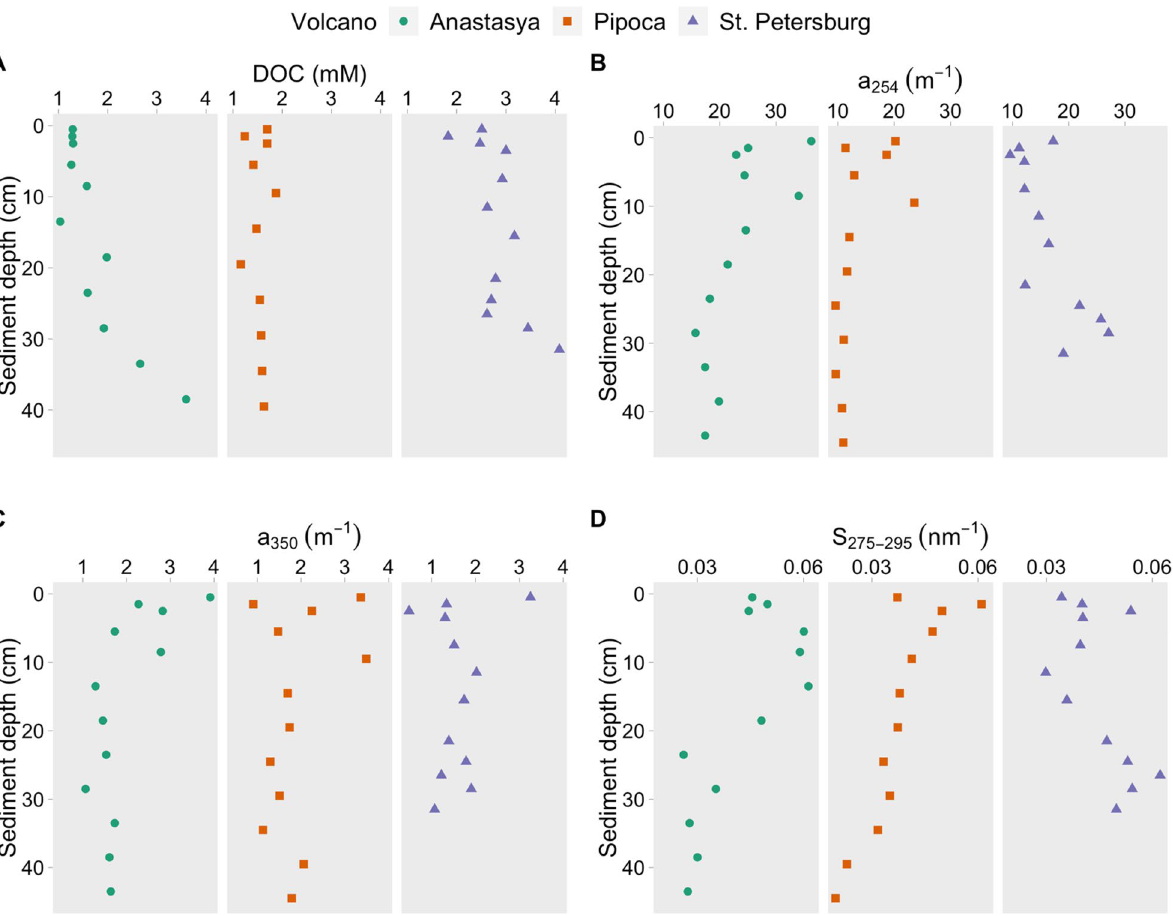
Figure 2. Pore water profiles of dissolved organic carbon ( A : DOC), absorption coefficients at 254 nm ( B ) and 350 nm ( C ) and the spectral slope S 275-295 ( D ) in the three mud